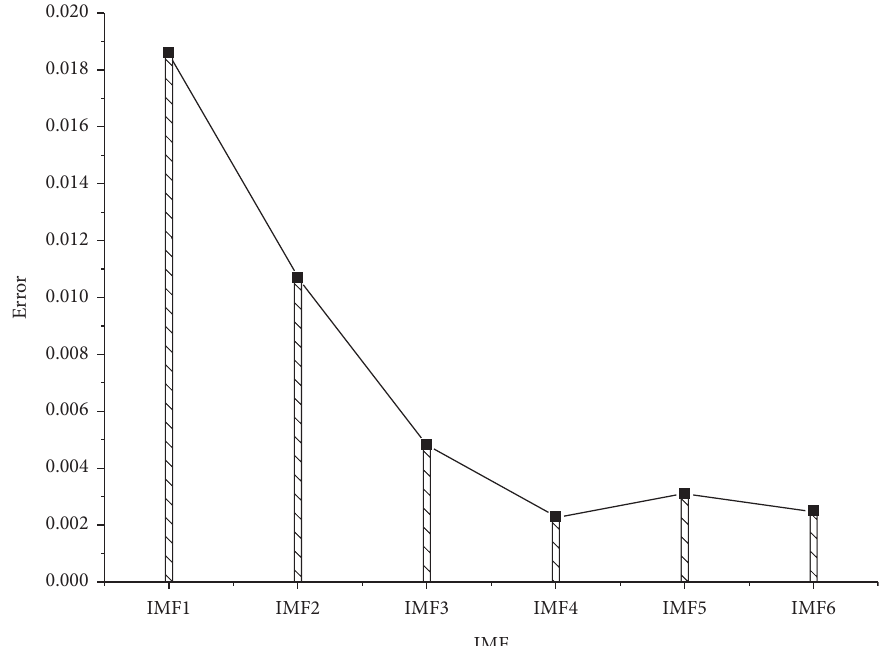
Figure 13: Error between the simulated VMD IMF central frequency and theoretical value for 3 # crack.